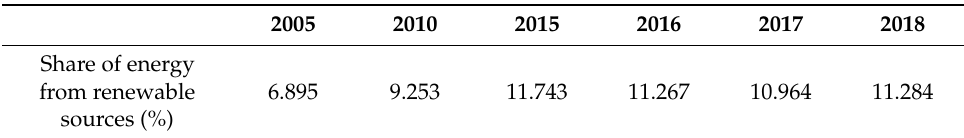
Table 7. Share of energy derived from renewable sources in gross final consumption of energy, in (%)